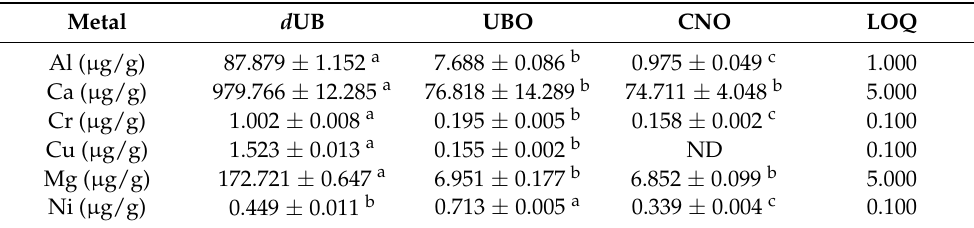
Table 1. The metals contents in dried U. barbata lichen ( d UB), U. barbata extract in canola oil (UBO) and canola oil